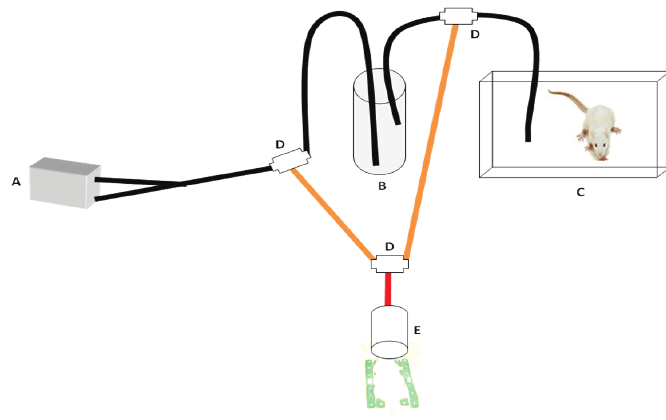
FIGURE 1 - Schematic design of the anesthesia equipment. A. Air compressor with two outlets (aquarium pump). B. Reservoir for inhalation agent. C. Inhalation chamber. D. Three-way stopcock for control of flow of anesthetic agent. E. Anesthetic mask for maintenance of anesthesia during the surgical procedure.